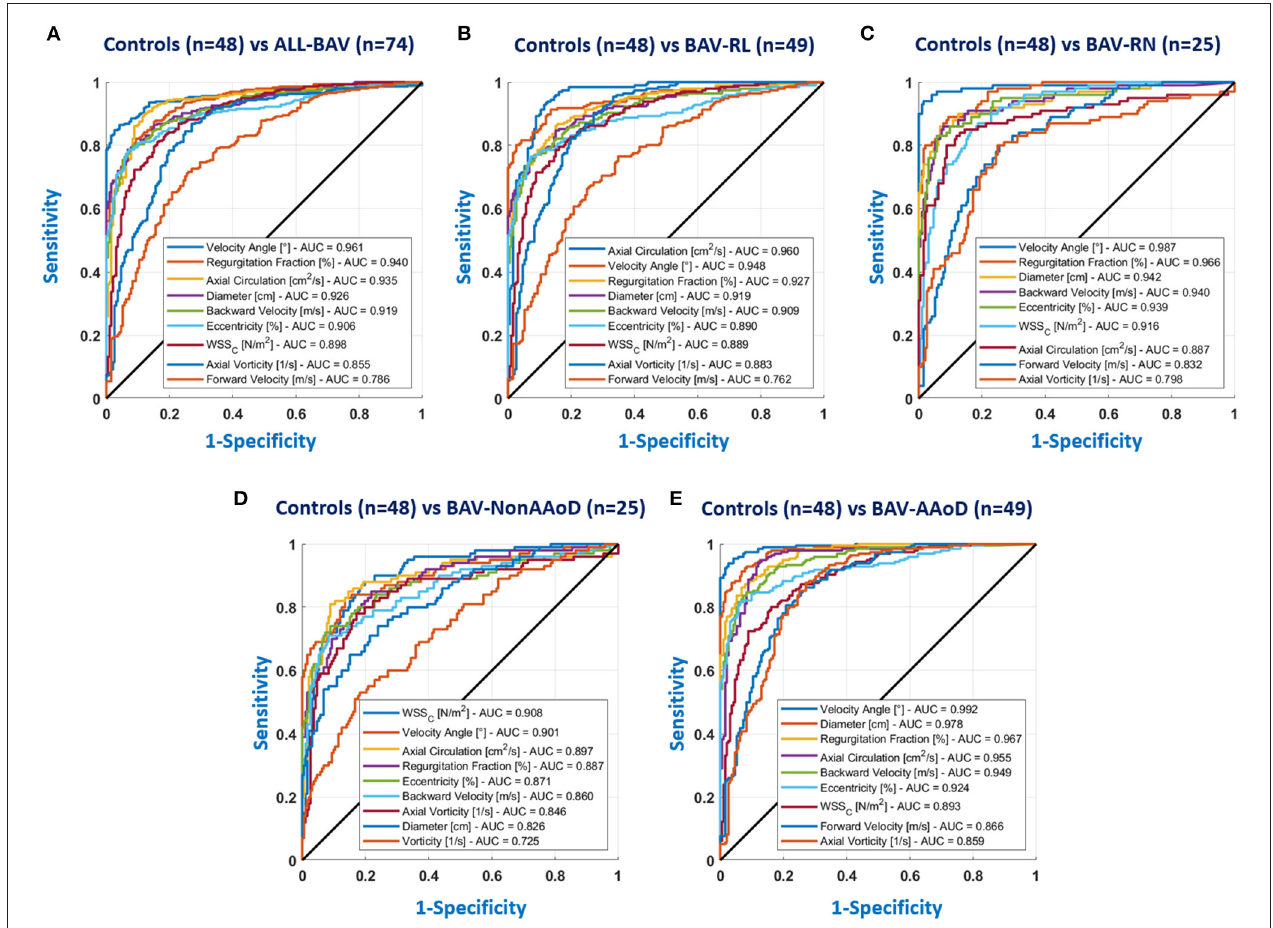
FIGURE 4 | ROC curves for the AAo; (A) HV vs. all BAV; (B) HV vs. BAV-RL; (C) HV vs. BAV-RN; (D) HV vs. BAV-Non-AAoD; (E) HV vs. BAV-AAoD. The parameters of the legend are the nine parameters with bigger area under the curve (AUC) values.